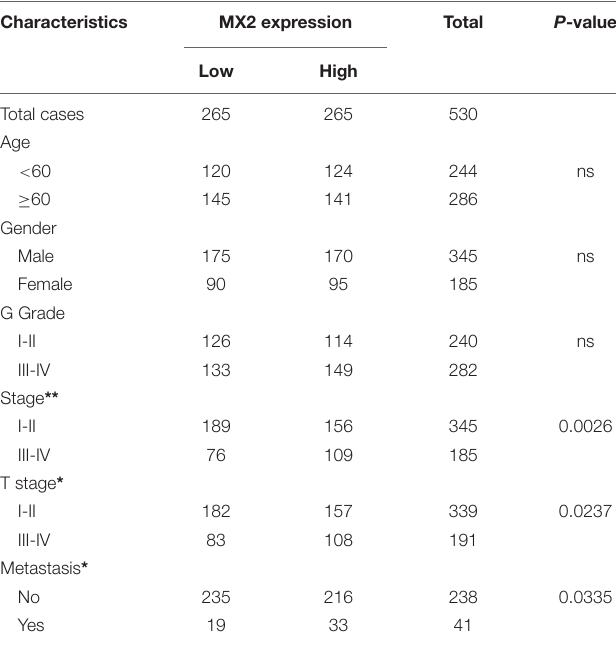
TABLE 1 | Correlation between MX2 level and clinicopathological parameters of ccRCC patients.